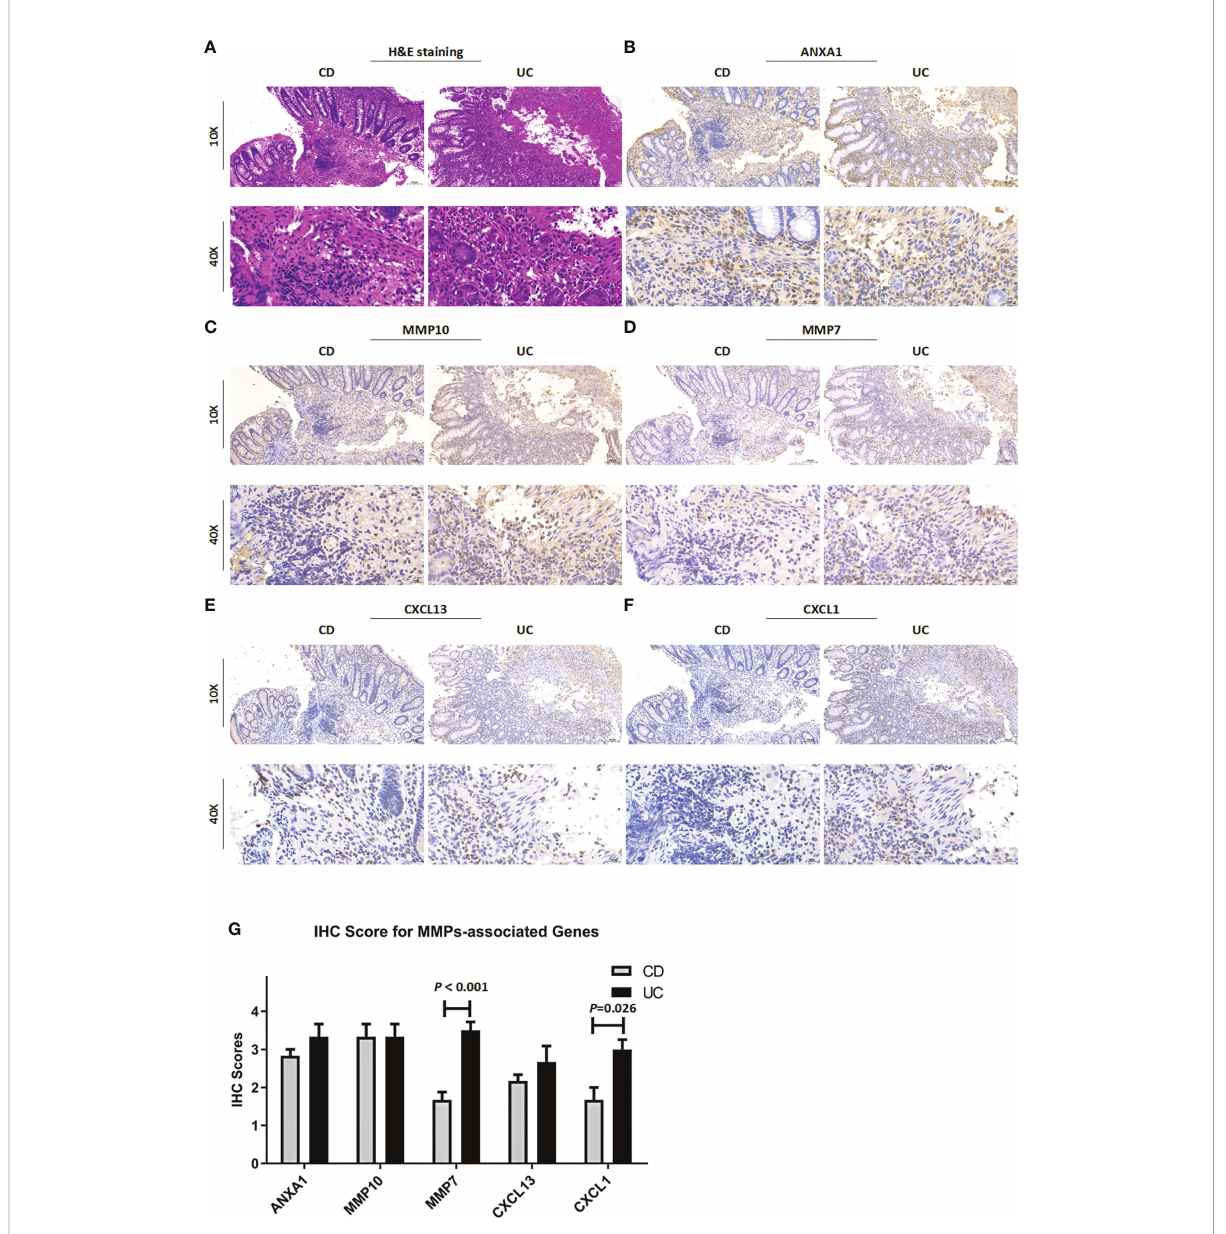
FIGURE 9 Clinicopathological examination of MMP-associated genes in tissue samples. (A) Representative images of H&E staining of samples from CD and UC patients. The IHC staining images are representative images of the expression levels of ANXA1 (B) , MMP10 (C) , MMP7 (D) , CXCL13 (E) and CXCL1 (F) in CD and UC samples. (G) IHC score difference analysis of MMP-associated genes in IBD patients. Statistical differences were analyzed by a Mann − Whitney U